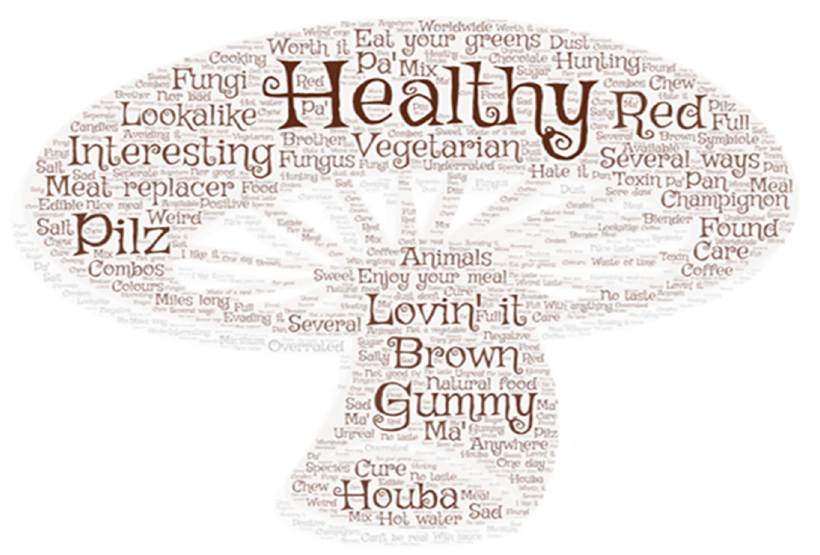
Figure 2. Word cloud of word associations related to mushrooms (source: own research, N = 598).